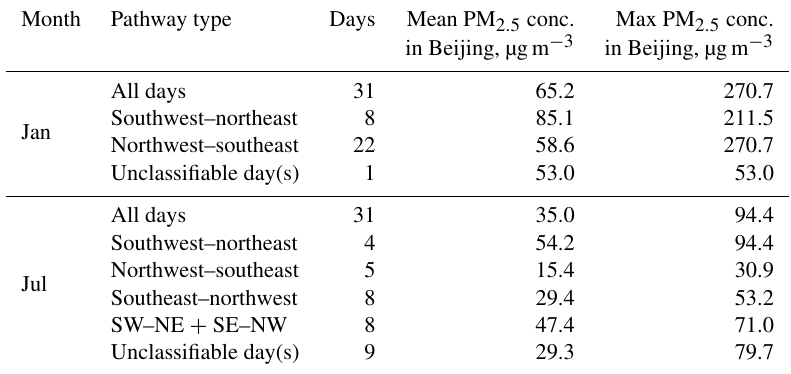
Table 3. The mean and maximum simulated PM 2 . 5 concentrations in Beijing for all days in January and July and for the days that belong to particular transport pathways.